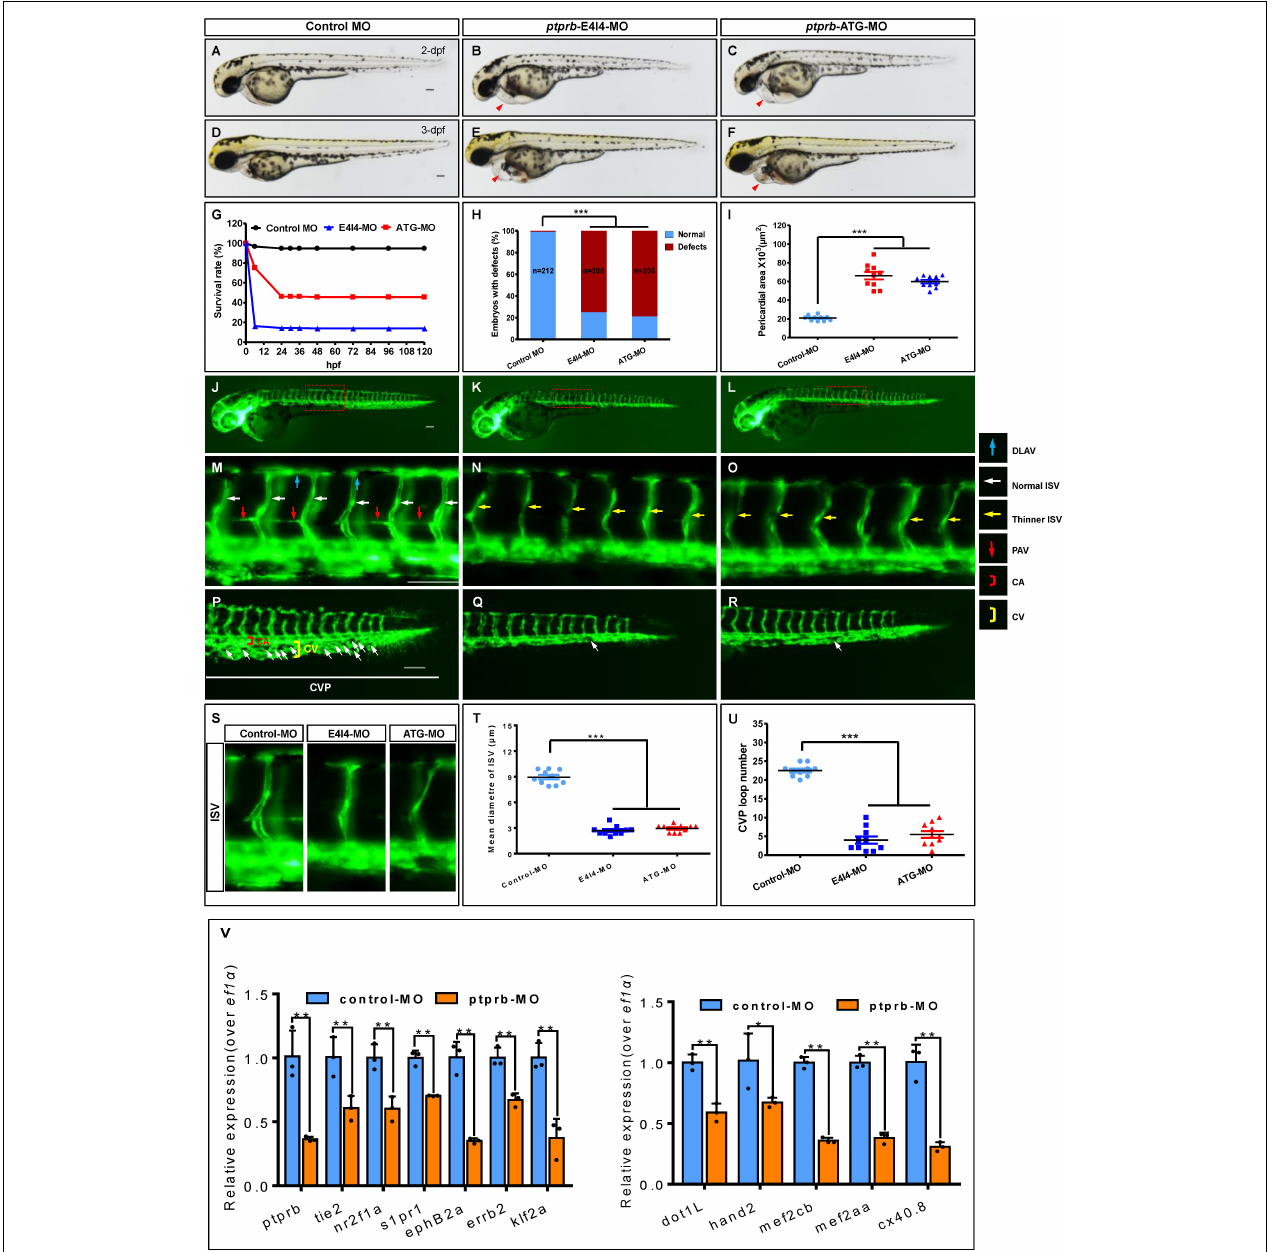
FIGURE 5 | Loss of ptprb phenocopies nxhl deficiency. (A–F) Gross morphology at 2- and 3-dpf. Compared with control zebrafish, ptprb knock-down causes pericardial oedema ( B,C,E,F , red arrowheads) and circulation defects. Heart beat and circulation in caudal vein (CV) is visible in the control fish, but is abnormal in ptprb morphants ( Supplementary Videos 3–8 ). (G) A time-course plot of percent survival in control vs. ptprb morphants for 3 days. (H) shows the percentage of embryos with development defects. (I) Quantification of the pericardial area of embryos. Error bars, mean ± SEM; *** p < 0.0001 ( n = 10; ANOVA). (J–R) Representative fluorescent images of Tg(fli1a:EGFP) y1 embryos at 2-dpf. (J,M) Image of trunk regions taken at 2-dpf, with the vascular structures visualized by eGFP fluorescence and labeled ISV and DLAV showed regular development in the embryo injected with control MO. The boxed regions are shown at higher magnification in the bottom panels. (K,L,N,O) Compared with control MO, embryos injected with ptprb -MO present thinner ISVs ( N,O , yellow arrows). In control embryos, the parachordal vessels (PAV) form normally ( M , red arrows). Compared with control, MO knock down ptprb prevents the parachordal vessels (PAV) formation, the precursor to the lymphatic system. In control embryos, caudal vein plexus (CVP) were formed honeycomb-like structures at the tail around 2-dpf ( P , white arrows). In contrast, ptprb knock down resulted in specific defects in caudal vein plexus (CVP) formation (Q,R) . (S–U) Quantification of the mean diameter ISVs (S,T) and loop formation at CVP (U) shows significantly decrease in ptprb morphants. Columns, mean; SEM ( n = 10; ANOVA) *** p < 0.0001. DLAV, dorsal longitudinal anastomotic vessels; ISV, intersegmental vessel; CVP, caudal vein plexus; CA, caudal artery; CV, caudal vein; dpf, days post fertilization. Scale bar, 100 µ m. (V) Expression of genes associated with angiogenesis (left) and heart development (right) post injection of ptprb MO 2-dpf using qPCR. The data represent as mean ± SEM from three independent experiments. * p < 0.05, ** p < 0.001 represents statistically significant.